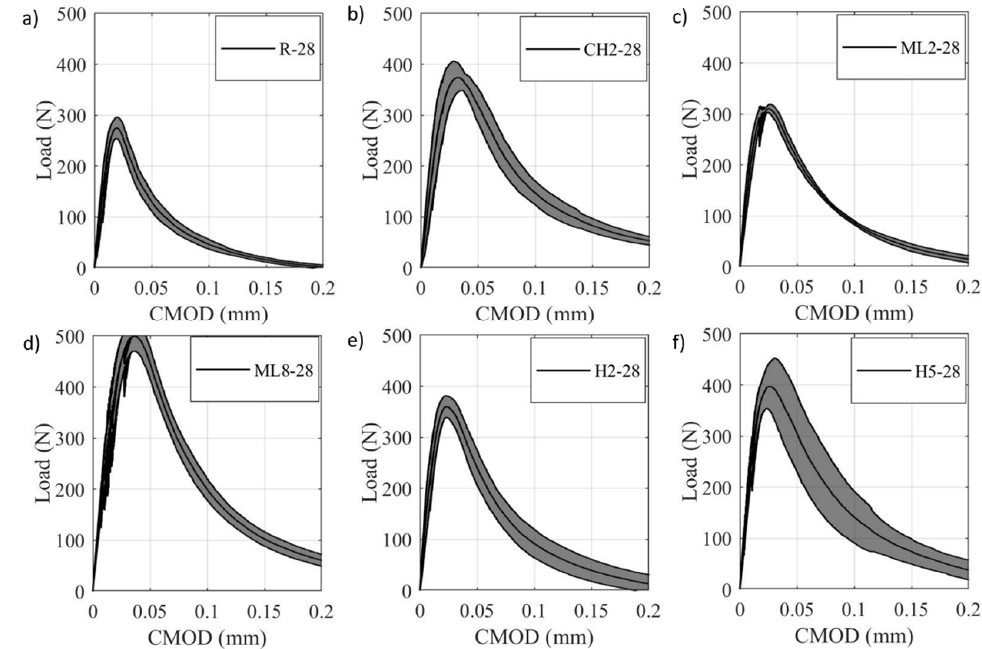
Figure 13. Comparison of CMOD mean and variance response for the ( a ) reference and carbon fiber reinforced cementitious composite mixes (( b ) CH2, ( c ) ML2, ( d ) ML8, ( e ) H2, and ( f ) H5) at 28 days of age. Each graph represents the mean of five tested samples.